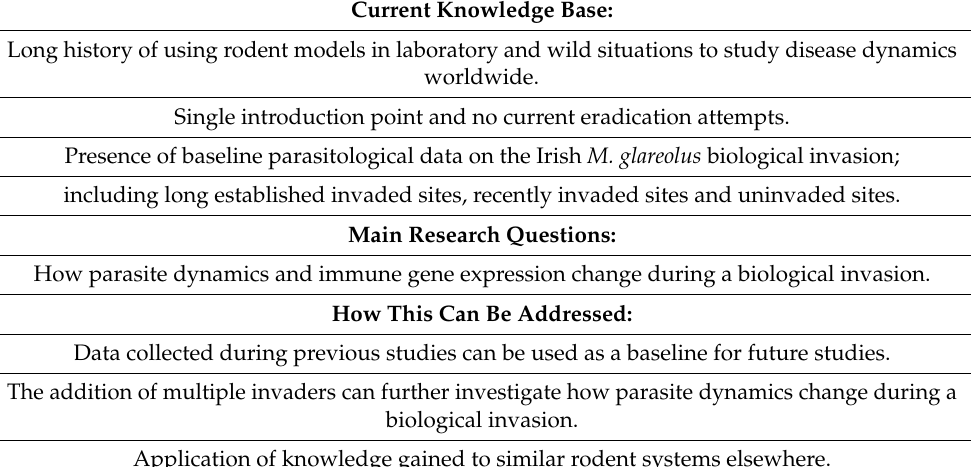
Table 2. Summary of current knowledge, main research question and how this can be addressed using M. glareolus as a model system in